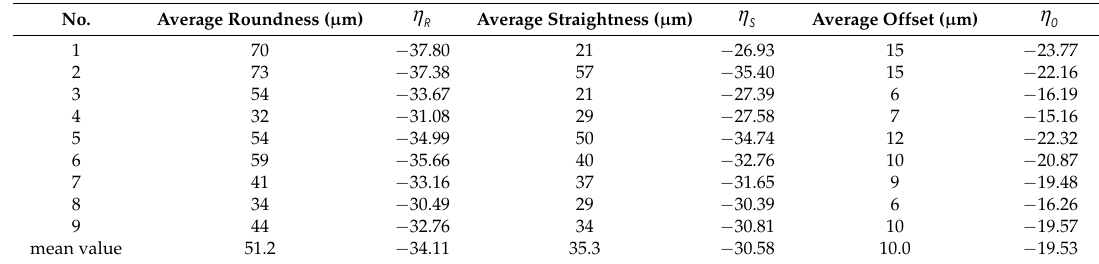
Table 4. Mean values of the response variable and its S/N ratio.